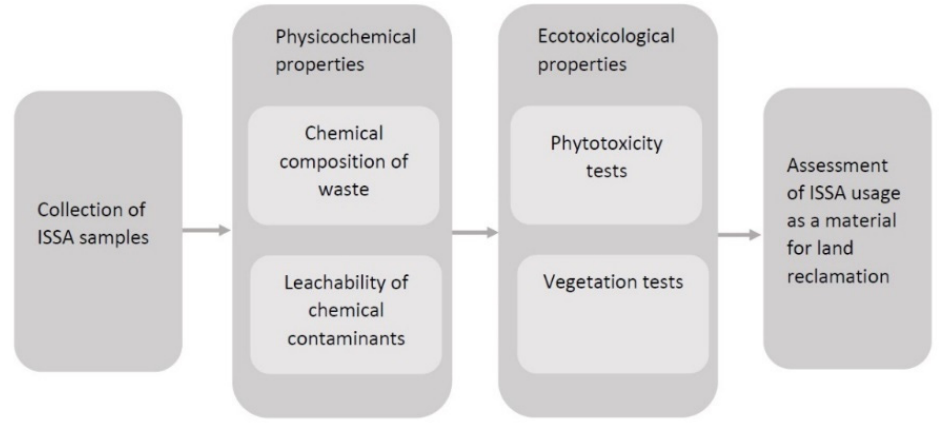
Figure 1. Research framework.